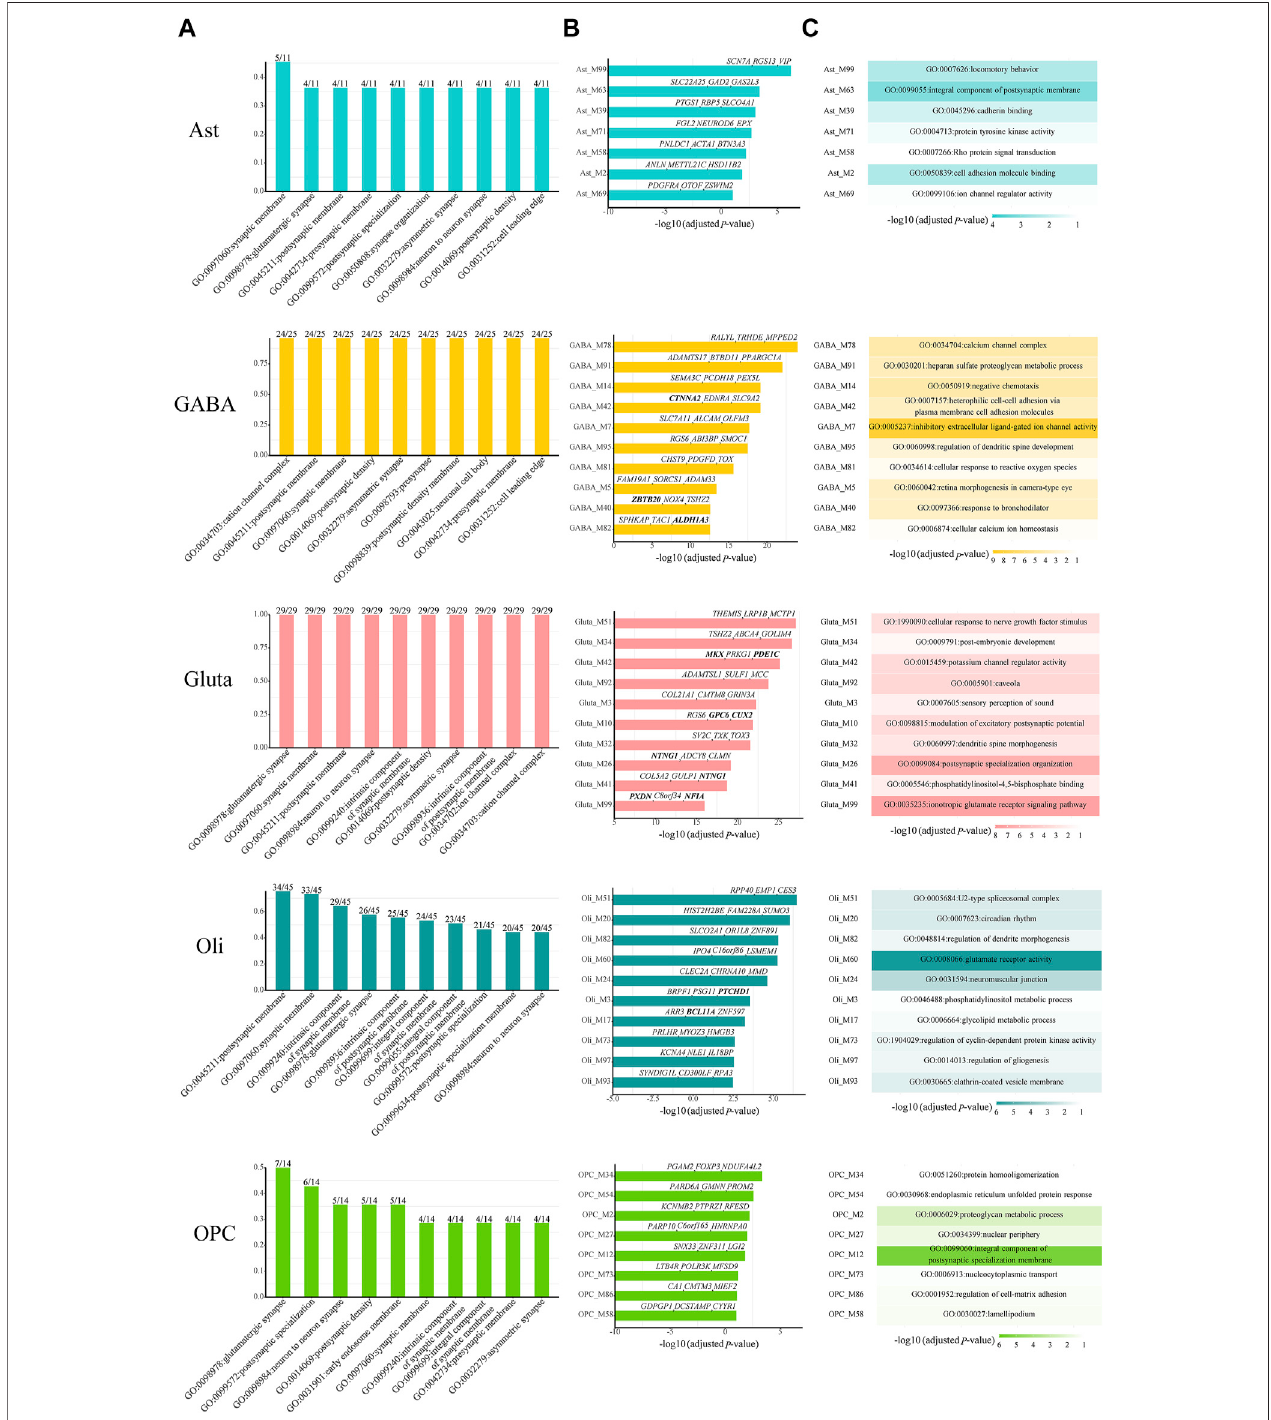
FIGURE 3 | (A) Top ten common enriched GO terms among all cell-type-speci fi c ASD-associated gene modules along with the frequency of occurrence and the totalnumberofcell-type-speci fi cASD-associatedgenemodules.Forthetoptencell-type-speci fi cASD-associatedmodules,whichhavemodule-speci fi cGOterms, (B) their Bonferroni-adjusted hypergeometric test p-values, top three z-score genes, and (C) top one GO term are shown. The SFARI ASD genes are bold. The Bonferroni- adjusted p-values were derived from the hypergeometric tests using module genes and ASD genes.